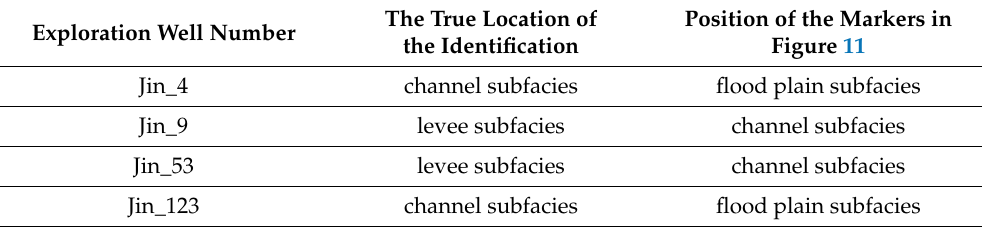
Table 2. Location difference of channel facies sediments in a fluvial facies sand-bearing map. The True Location of Position of the Markers in Exploration Well Number the Identification Figure 11 Jin_4 channel subfacies flood plain subfacies Jin_9 levee subfacies channel subfacies Jin_53 levee subfacies channel subfacies Jin_123 channel subfacies flood plain